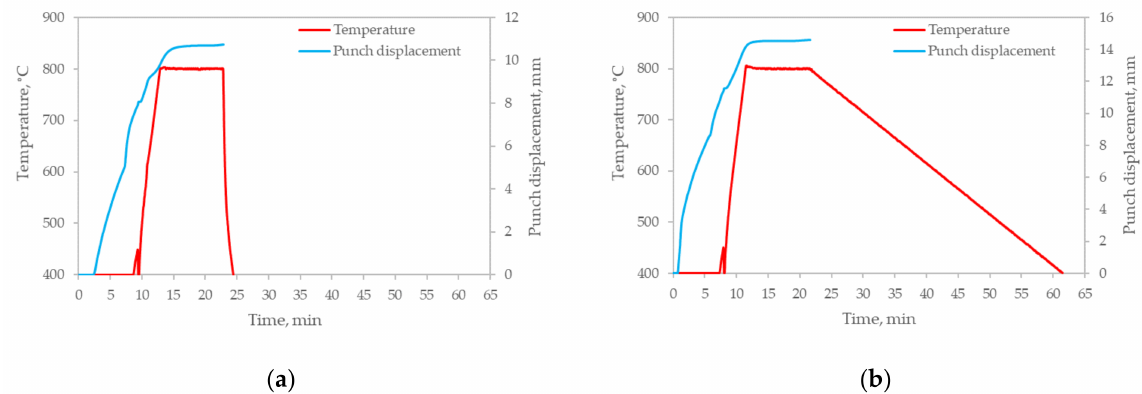
Figure 3. Sintering curves of zirconium powder spark plasma sintered at 800 ◦ C at various cooling rates: ( a ) 400 ◦ C/min; ( b ) 10 ◦